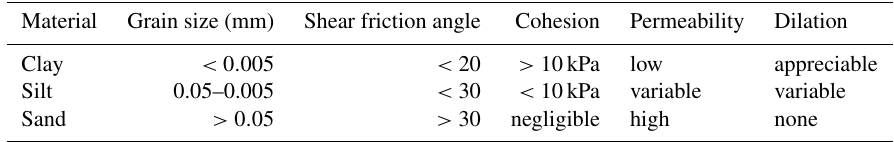
Table 3. General properties of sediments relating to composition and texture (see also Eq. 1). Material Grain size (mm) Shear friction